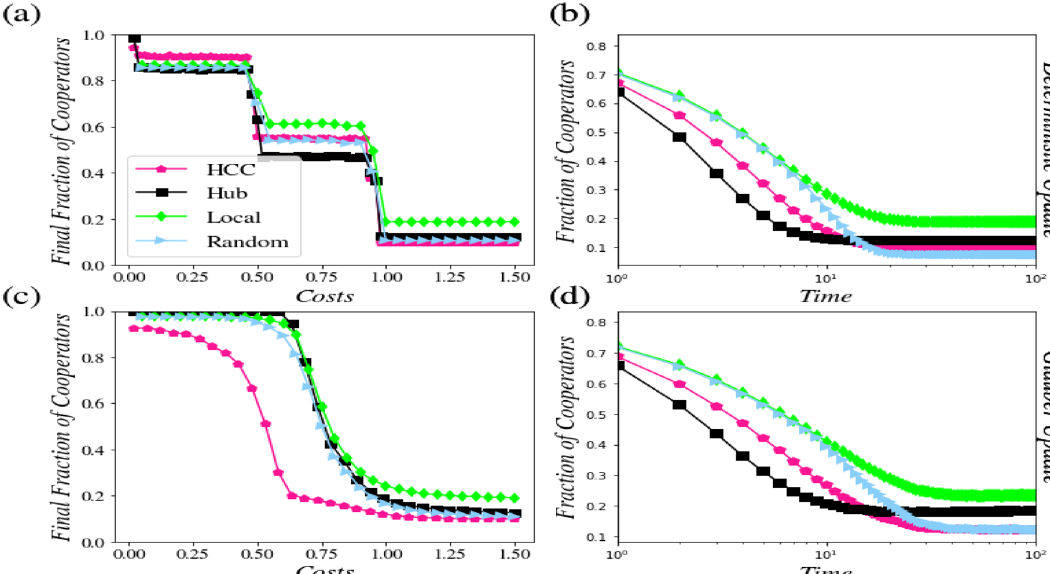
Figure 4. Results of the s420 network. ( a ) An analysis of the cooperation level based on the deterministic update rule. ( b ) The network dynamics in achieving a steady state under the deterministic update rule ( c = 1 ). ( c ) An analysis of the cooperation level based on the Glauber update rule. ( d ) The network dynamics in achieving a steady state under the Glauber update rule ( c = 1